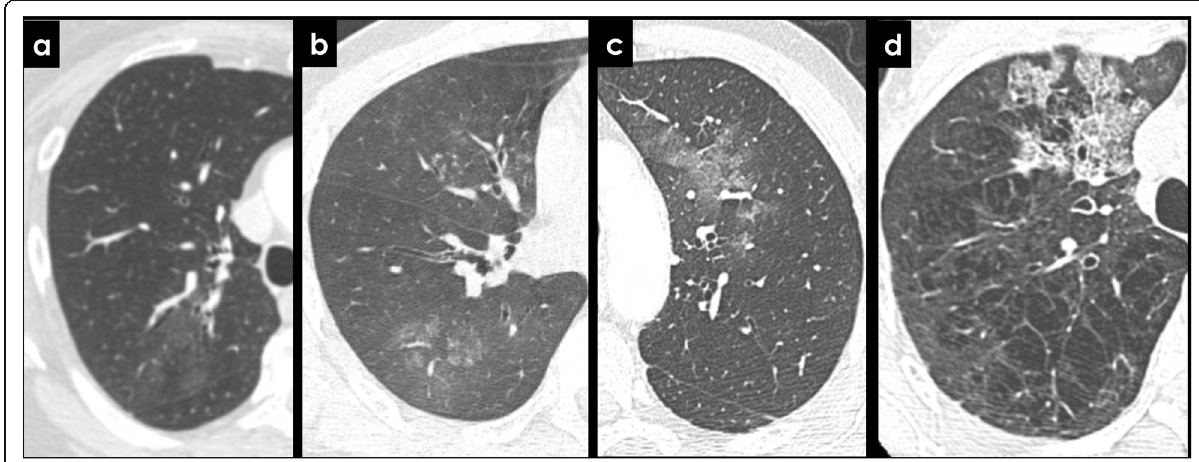
Fig. 12 CT findings of pulmonary hemorrhage. Hazy ground-glass infiltrates ( a , b , c ) representing intra-alveolar hemorrhage in patients with hemoptysis. Also note endobronchial filling in b and crazy paving pattern in